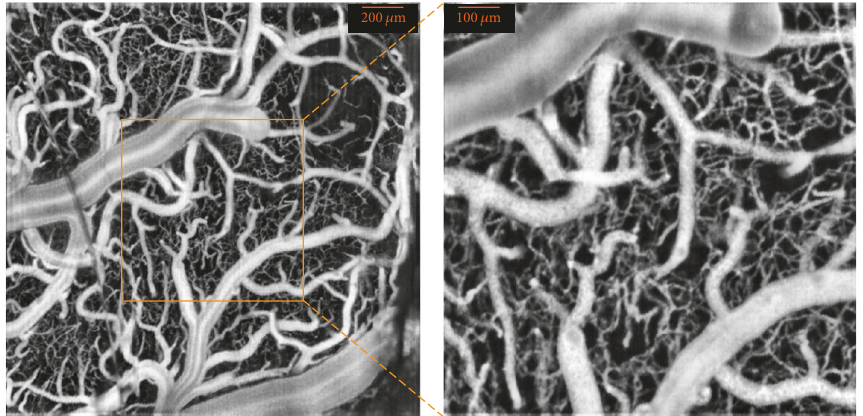
Figure 10: OCT angiography of capillaries in a rat brain. The imaging resolution system allows for imaging vasculature and small capillaries in the cortex of a rat. The image is the maximum intensity projection of a thickness of ∼ 220 𝜇 m after averaging 5 angiography recordings [46].